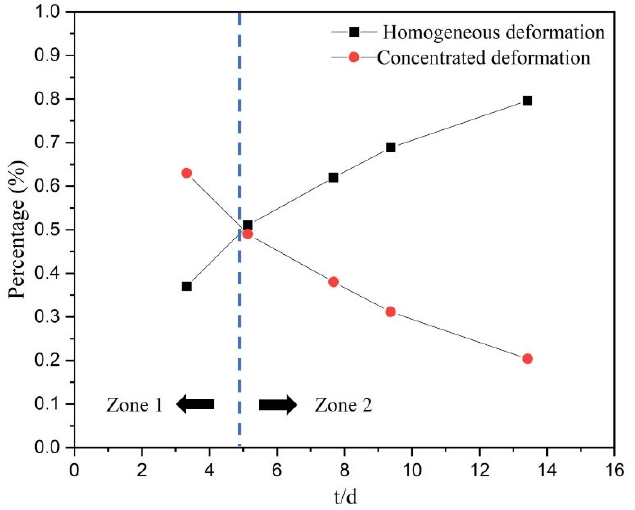
Figure 7. The percentage of homogeneous deformation amount and concentrated deformation amount of various Ti-2.5Al-1.5Mn foils.